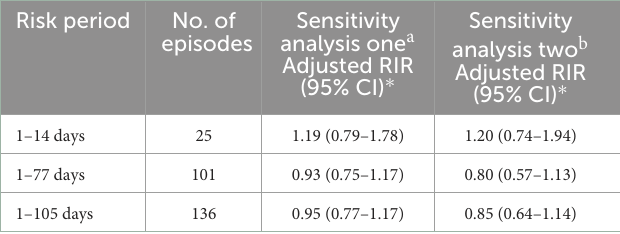
TABLE 3 Sensitivity analysis for relative incidence ratio of PFP after IIV3